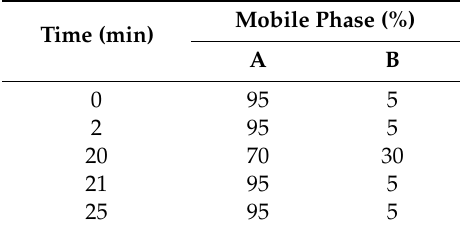
Table 2. Gradient used for the liquid chromatography (LC) mobile